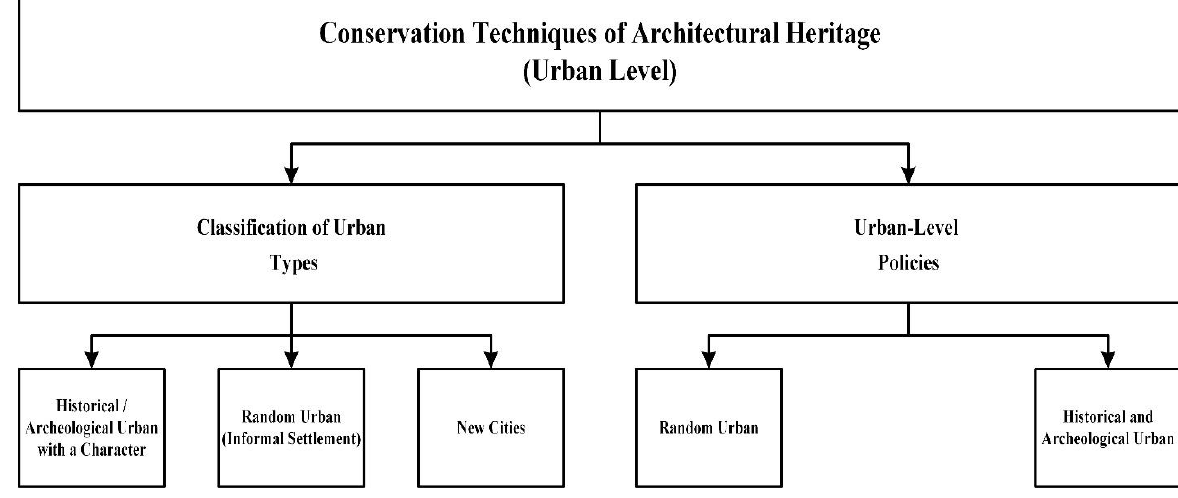
Figure 2: The conservation techniques of architectural heritage – Urban level